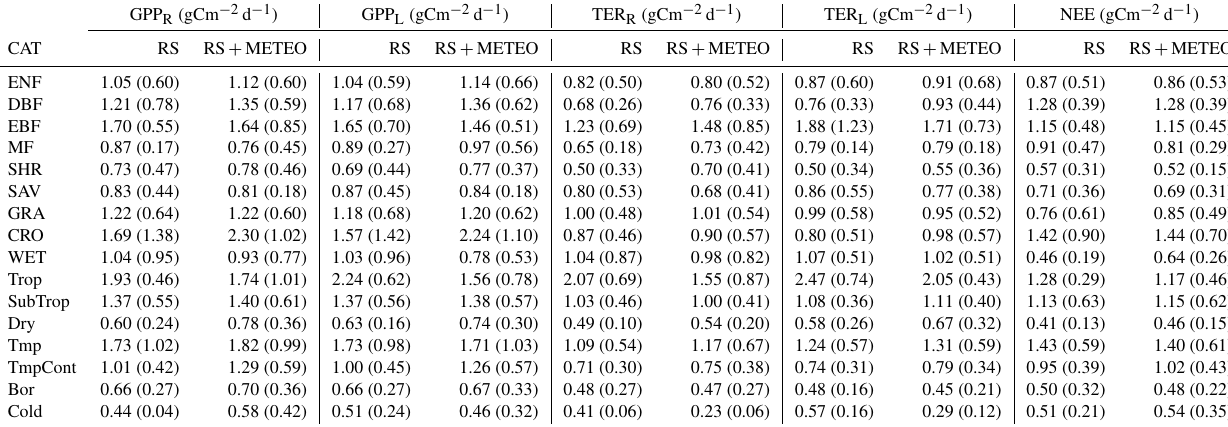
Table C2. Median site-by-site RMSE and its standard deviation (in parentheses and estimated as reported in Jung et al., 2009) for the CO 2 fluxes per PFT and climate zones. List of acronyms: ENF, was evergreen needleleaf forest; DBF, deciduous broadleaf forest; EBF, evergreen broadleaf forest; MF, mixed forest; SHR, shrubland; SAV, savannah; GRA, grassland; CRO, cropland; WET, wetland; Trop, tropical; SubTrop, subtropical; Dry, dry and arid land; Tmp, temperate; TmpCont, temperate–continental; Bor, boreal; Cold, cold and polar environment or covered by